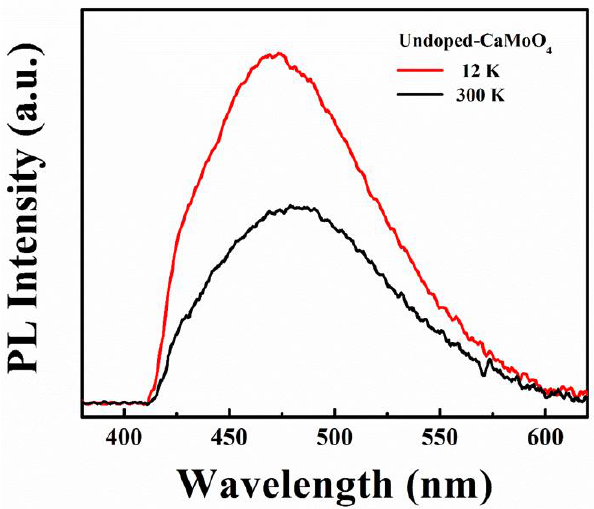
Figure 2. 12 and 300 K PL spectra of undoped-CaMoO 4 phosphors.